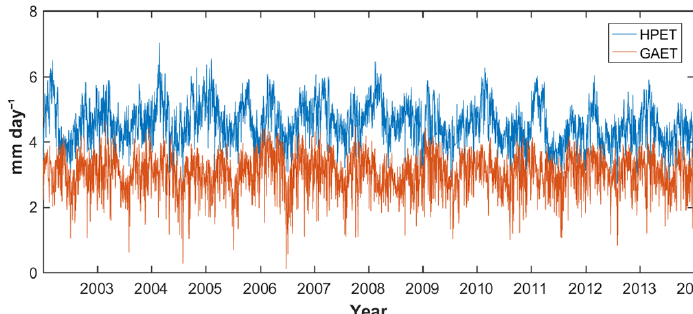
Figure 3. Time series of HPET and GAET for the Nyangores River basin.